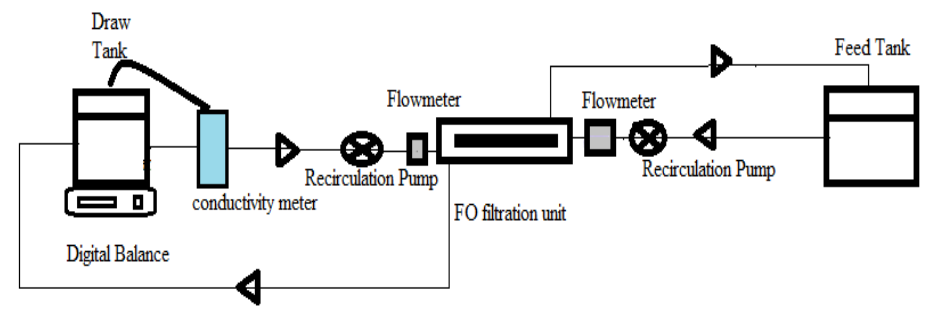
Figure 1. The schematic diagram for bench scale forward osmosis (FO)